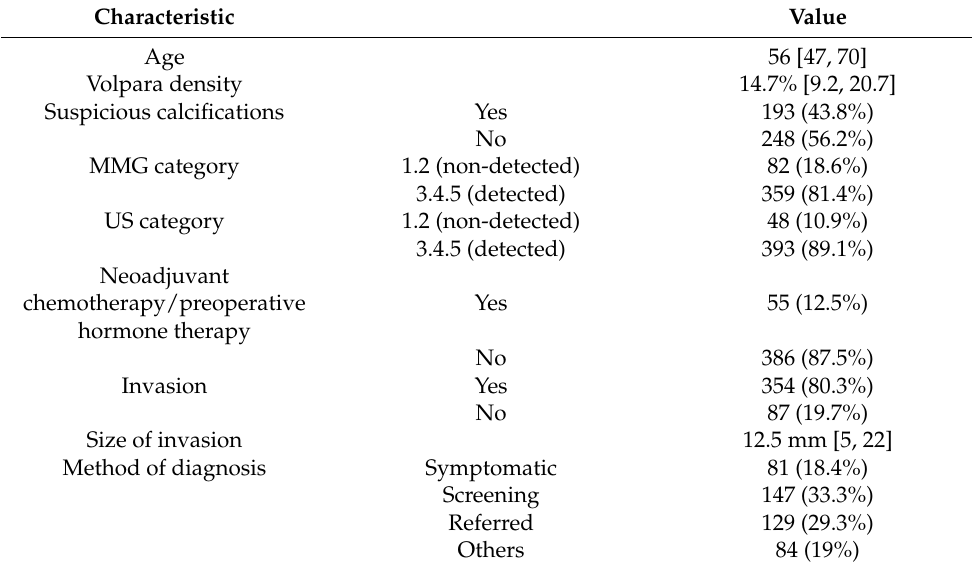
Table 1. Breakdown of the patient population ( N =